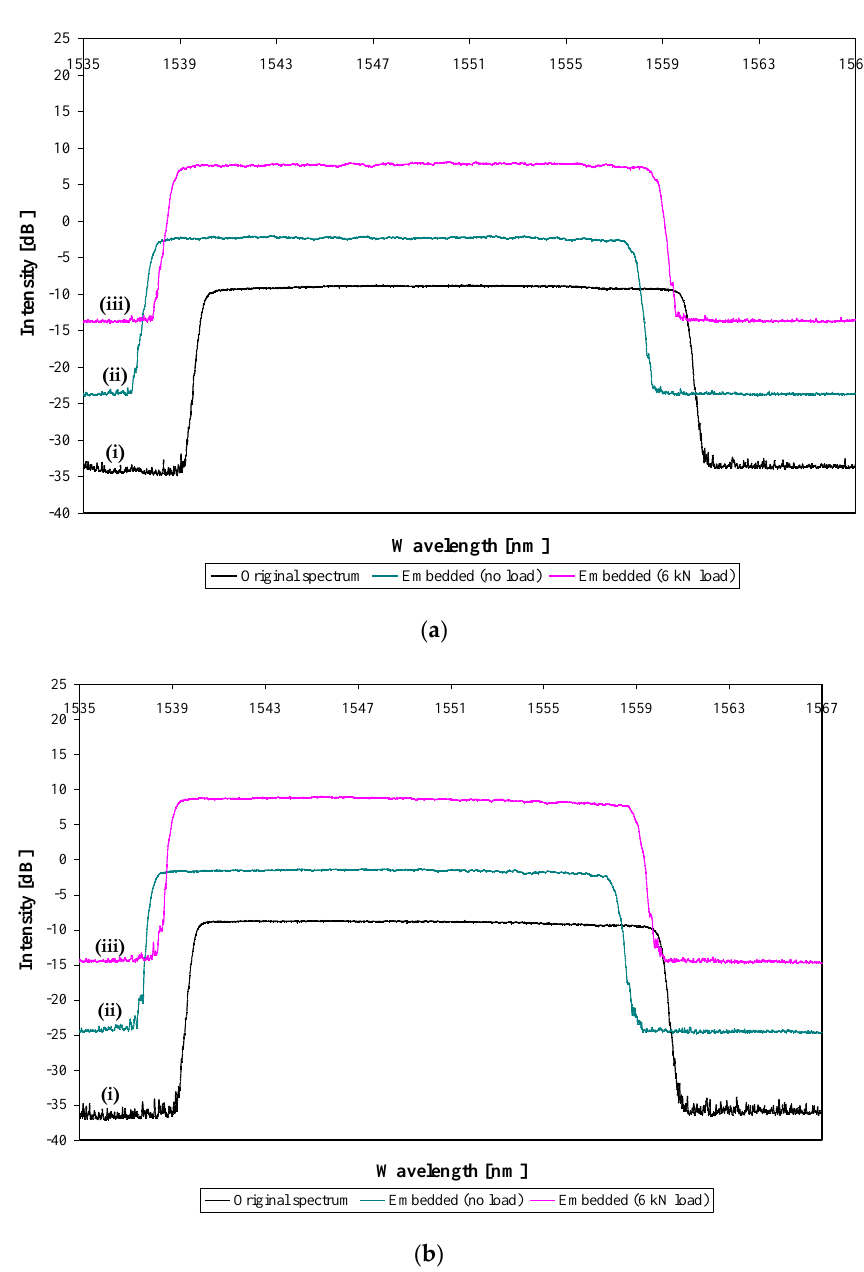
Figure 6. Reflected spectra of repaired but undamaged specimens ( a ) S1 and ( b ) S2 with (i) the sensor unembedded and unloaded, (ii) the sensor embedded and the specimen loaded at 0 kN, and (iii) the sensor embedded and specimen loaded at 6 kN.